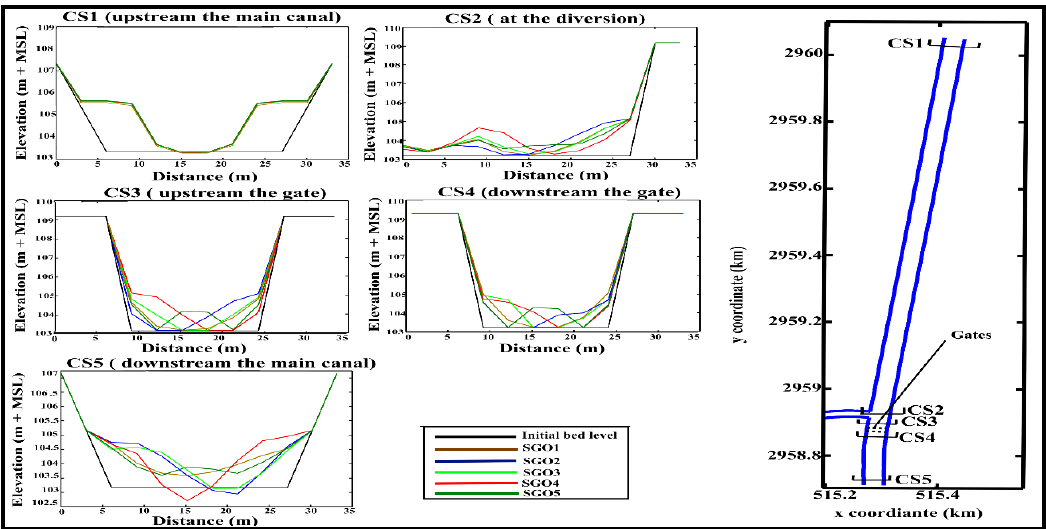
Figure 11. The bed level within different cross-sections in scenarios with two open gates.